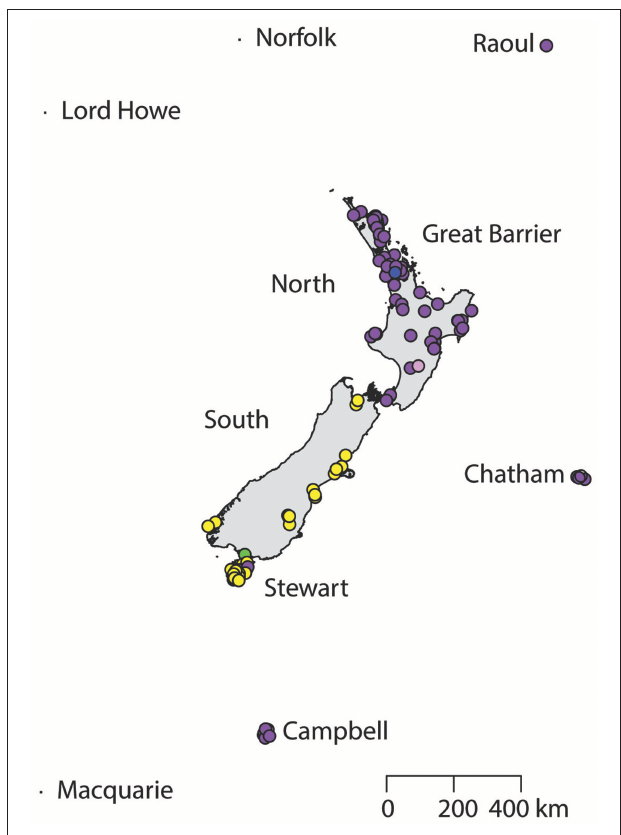
FIGURE 2 | The distribution of R. norvegicus haplotypes across New Zealand and surrounding islands.